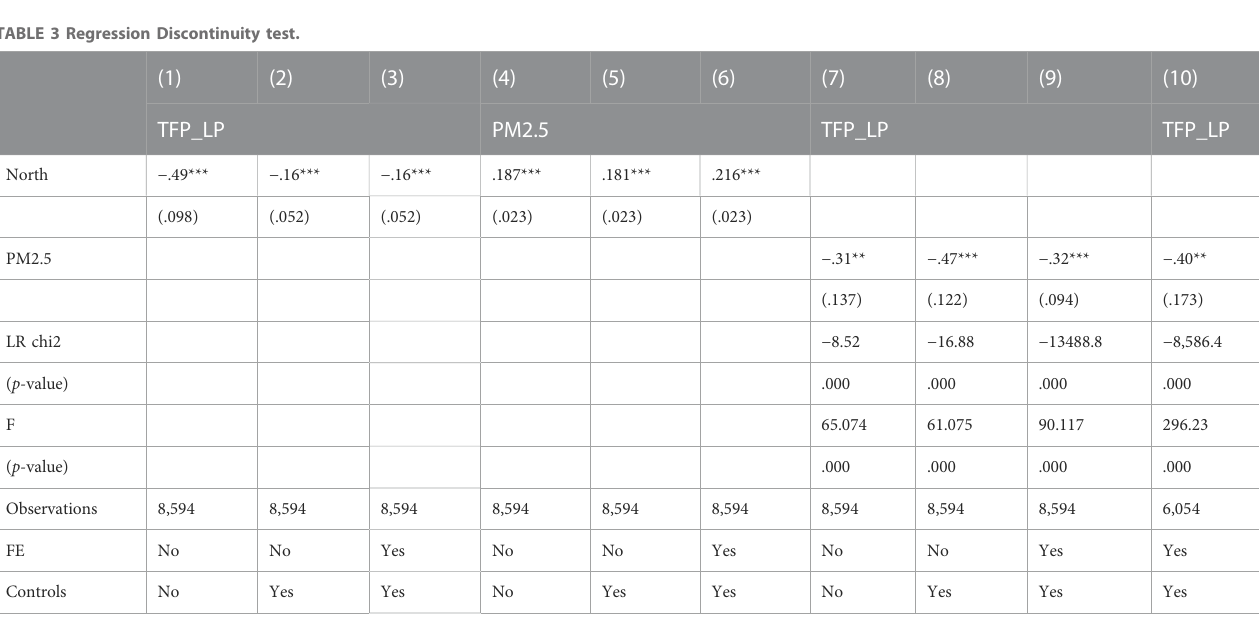
TABLE 3 Regression Discontinuity